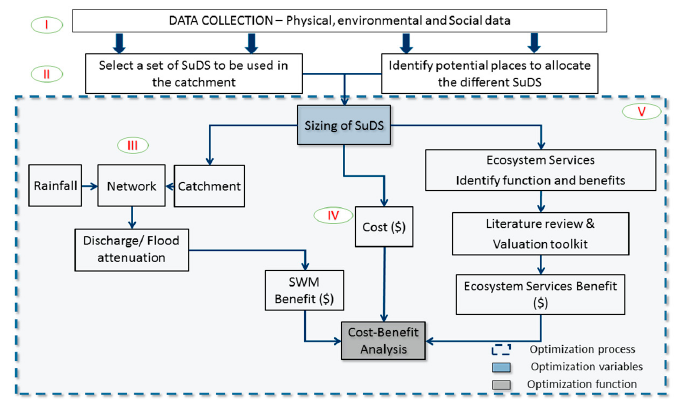
Figure 1. Research framework.